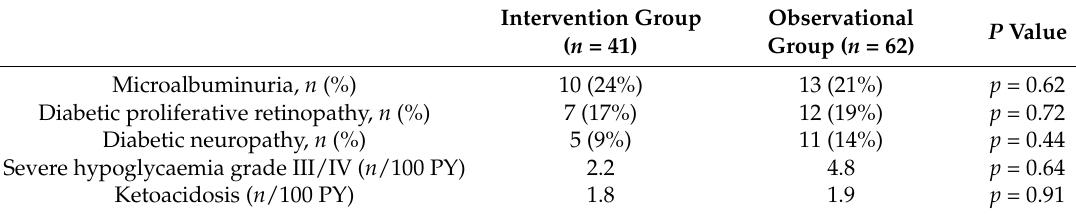
Table 3. Diabetic and microvascular complications diagnosed during follow-up. Intervention